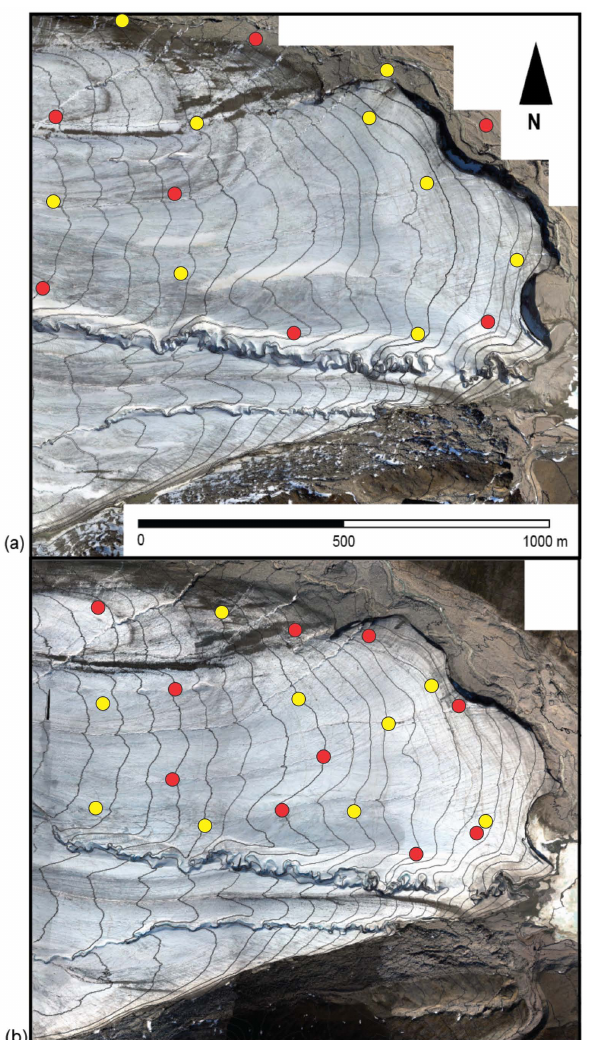
Fig. 2. Orthomosaic images of the glacier terminus from (a) 2010 (UAV) and (b) 2011 (piloted helicopter). Contour interval is 10m. Red dots indicate GCPs, while yellow dots show check points used for each